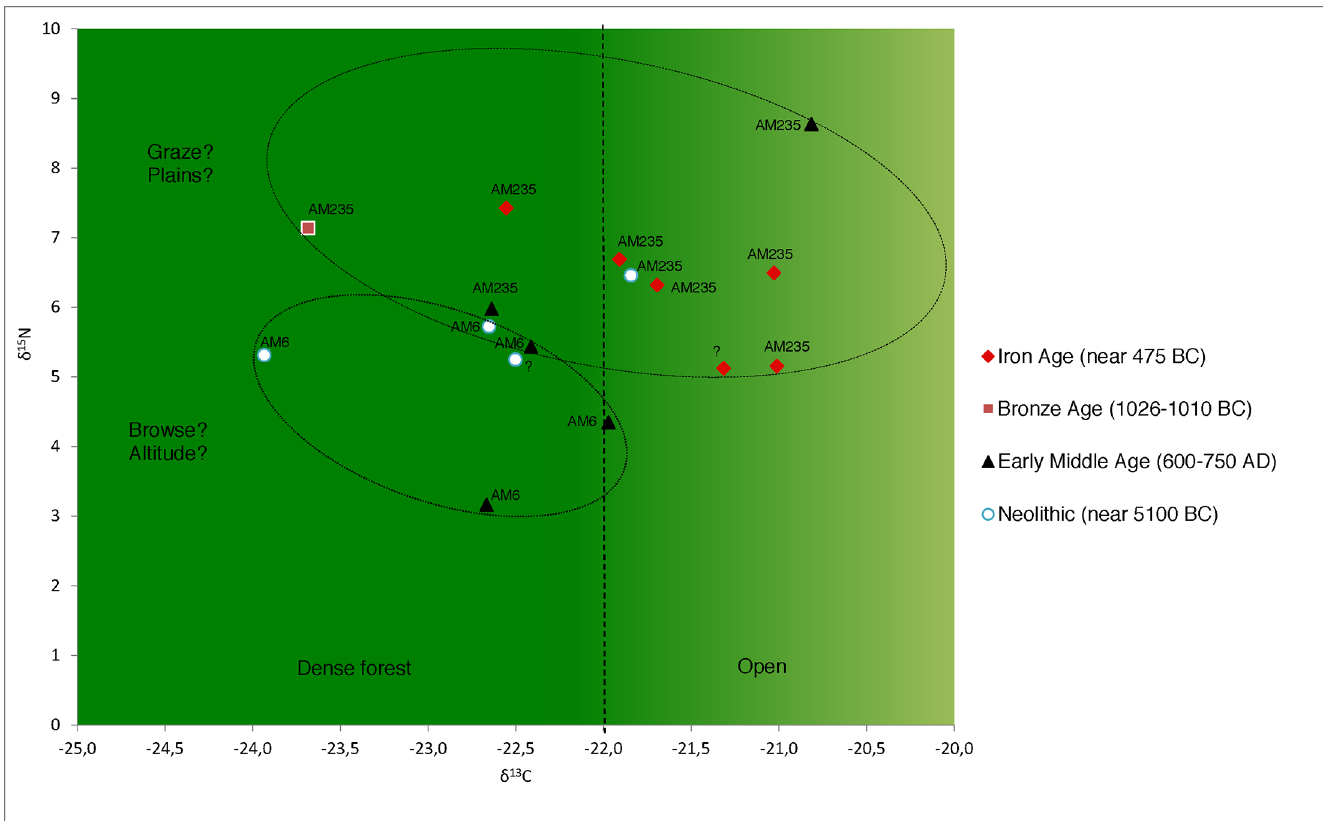
Fig 4. Scatter-plot of δ 13 C and δ 15 N values for archaeological red deer collagen according to their age and haplotype. Ellipses are drawn manually to encompass samples with the same haplotype. One ellipse (below) corresponds to individuals living deep in the forest (mostly browser habits); the other (above) individuals living in open habitats or open (plain) or herb-rich woodlands of the adjacent